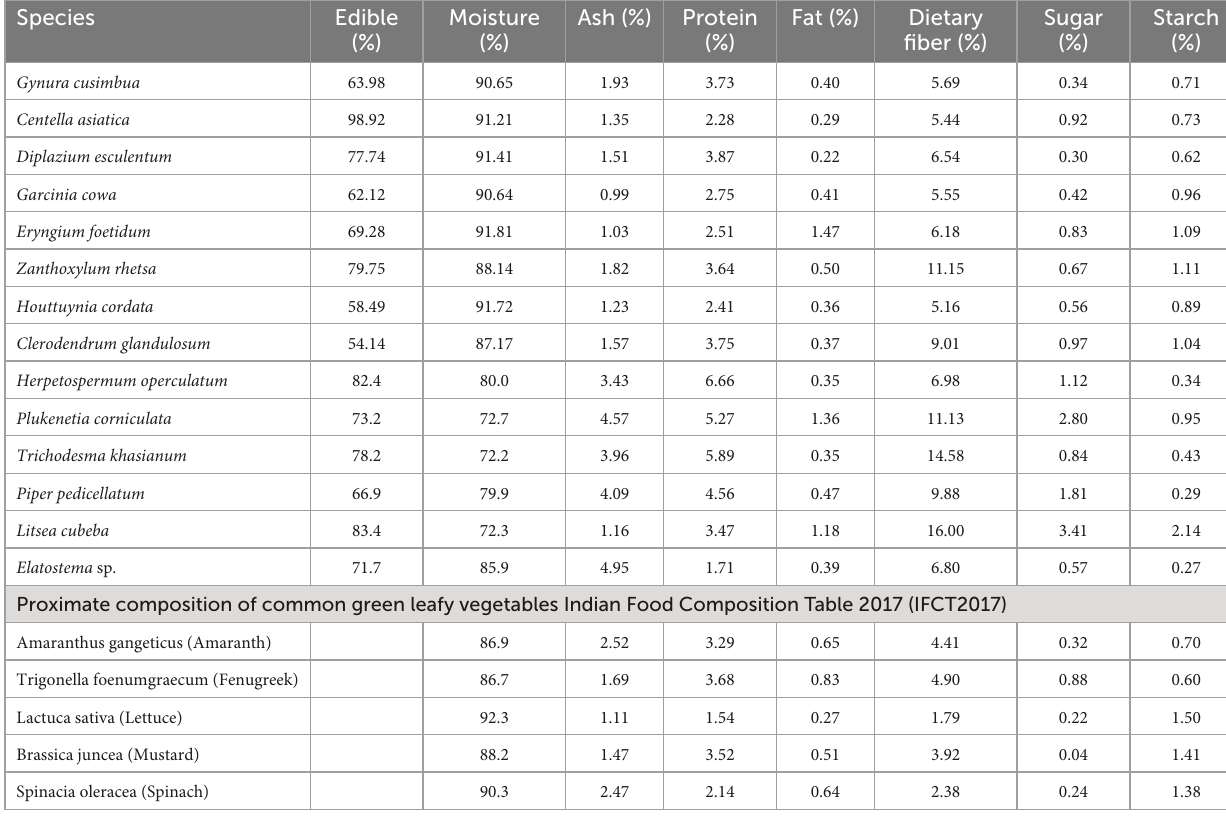
TABLE 1 Proximate composition of wild edible plants of North Eastern region, India. Species Edible